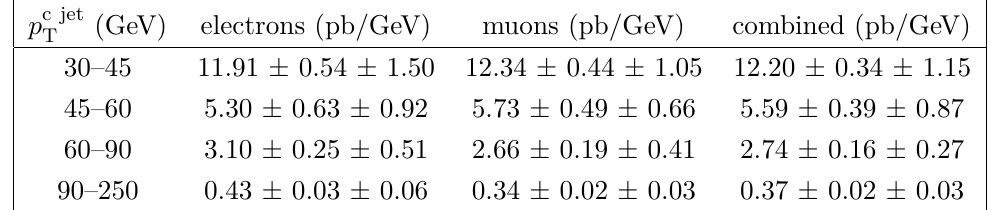
for electron and muon channels T